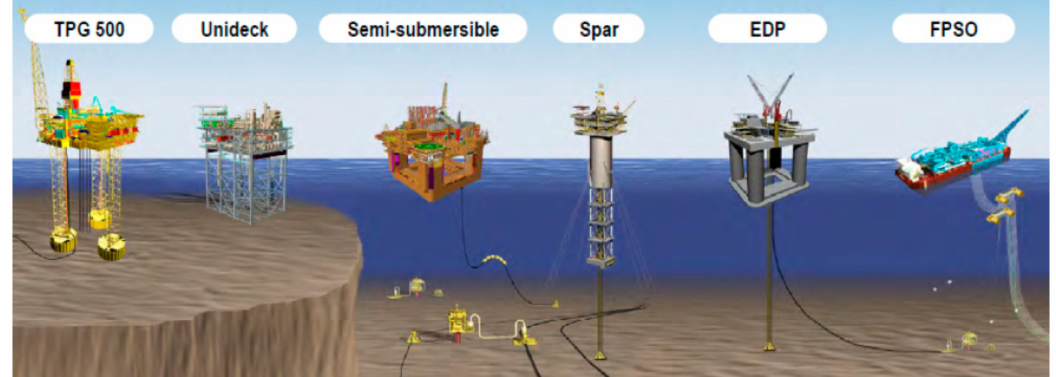
Figure 10. Typical floating structures used in the oil and gas industry